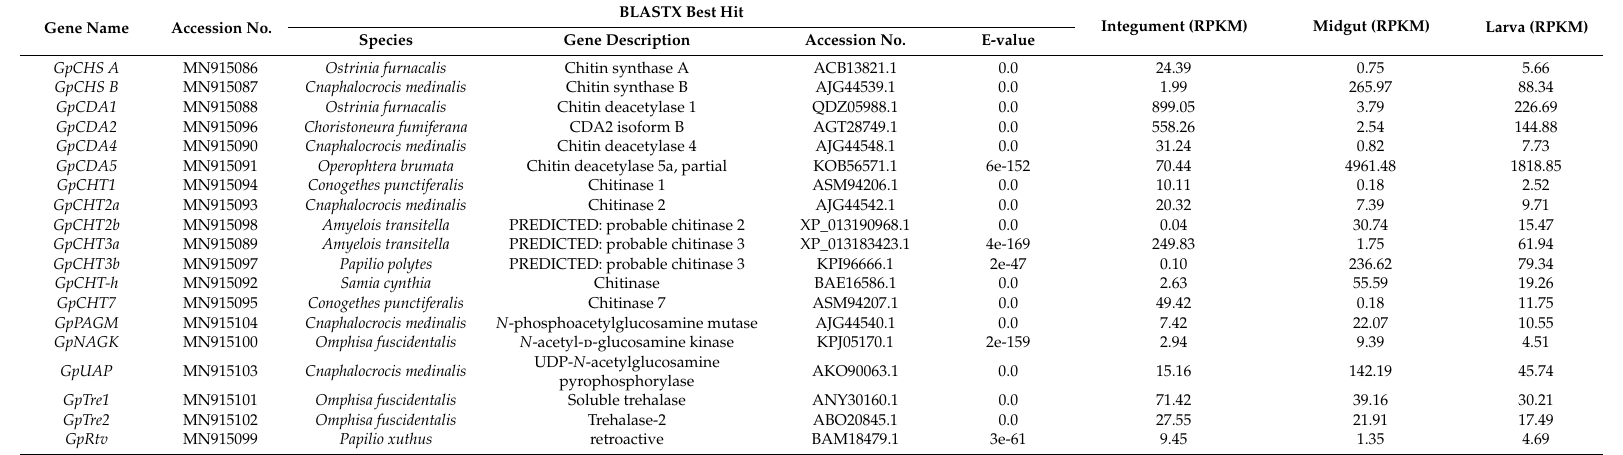
Table 2. Identification of major enzyme genes involved in the chitin metabolism of G. pyloalis